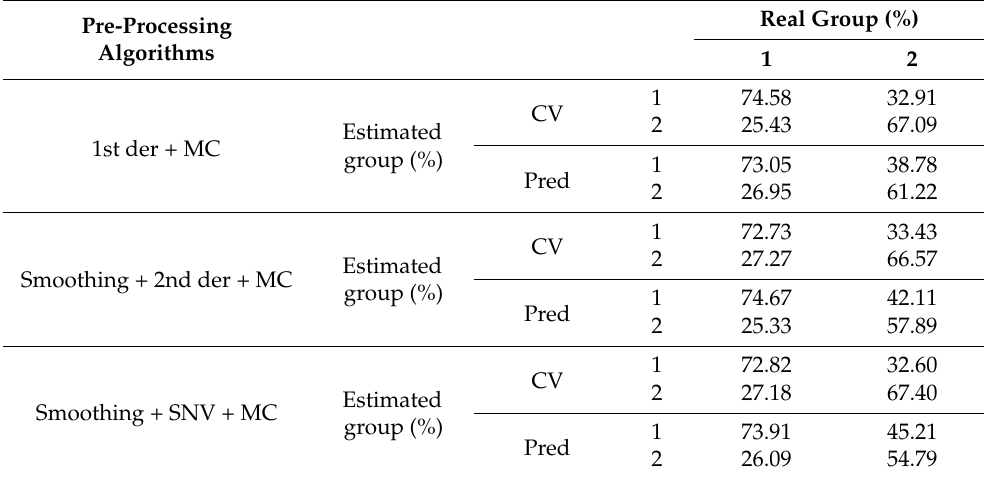
Table 3. Confusion matrix for the 3 PLS-DA models